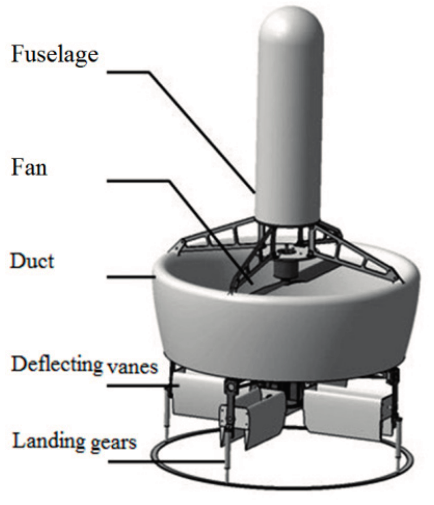
Figure 1. The prototype ducted fan